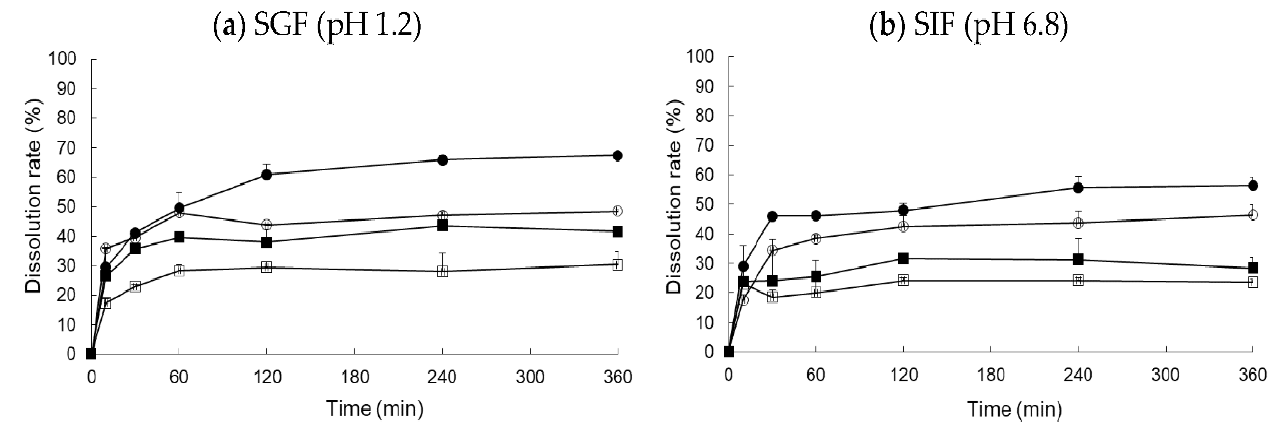
Figure 9. Food-effect dissolution rate of optimized RXB-ASD and a commercial tablet (Xarelto ® , 20 mg) in simulated gastric fluid (SGF, pH 1.2) and simulated intestinal fluid (SGF, pH 6.8). (Key: ○ : Optimized RXB-ASD in FaSSGF (or FaSSIF), □ : Xarelto in FASSGF (or FaSSIF), ● : Optimized RXB-ASD in FeSSGF (or FeSSIF), ■ : Xarelto in FeSSGF (or FeSSIF).